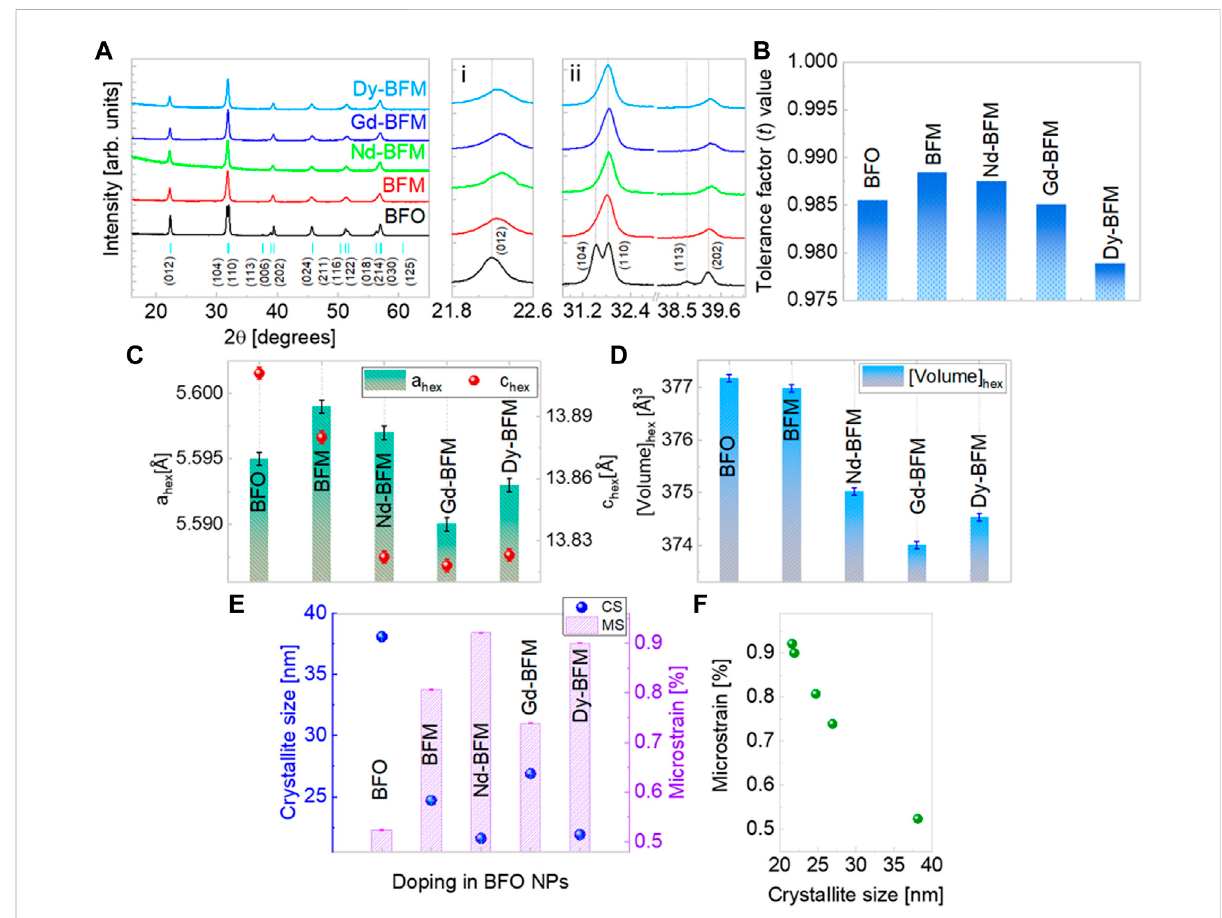
FIGURE 1 X-raydiffractogramsofrareearth(Nd,Gd,Dy)dopedBFMNPs( A ,i,ii)alongwithpeakindexingbasedonICSDdatabase.Tolerancefactortrend indopedBFONPs (B) ,latticeparametersvariationinhexagonalstructure (C) ,unitcellvolume (D) ,andcrystallitesizeandmicrostrainvaluesindoped BFO NPs (E) , Linear relation between microstrain and crystallite size of NPs (F)